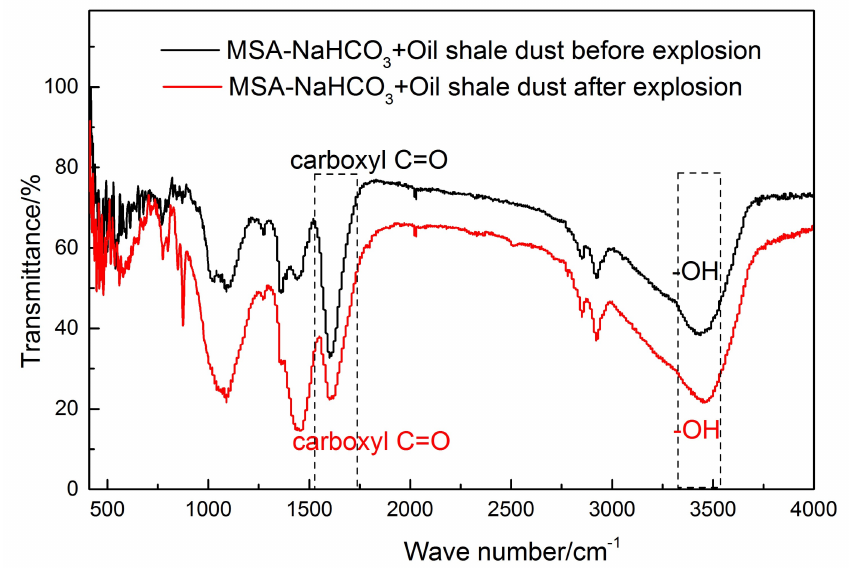
Figure 13. The FTIR analysis results of the explosion suppression of oil shale dust by MSA–NaHCO 3 composite